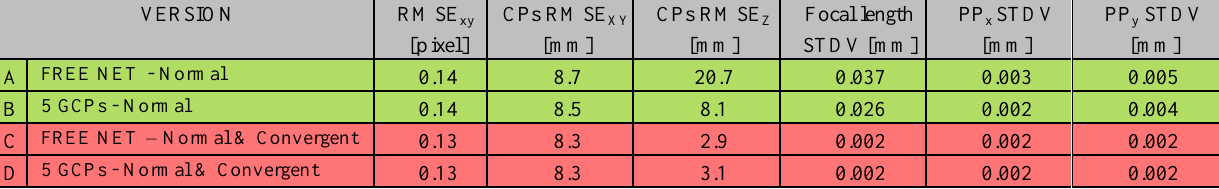
Table 2: RMSE of image observations and check points (CP) and STDV of interior parameters (focal length, x-coordinate PPx and y- coordinate PPy of principal point) in the different bundle adjustment versions and network configurations (image GSD < 1.5